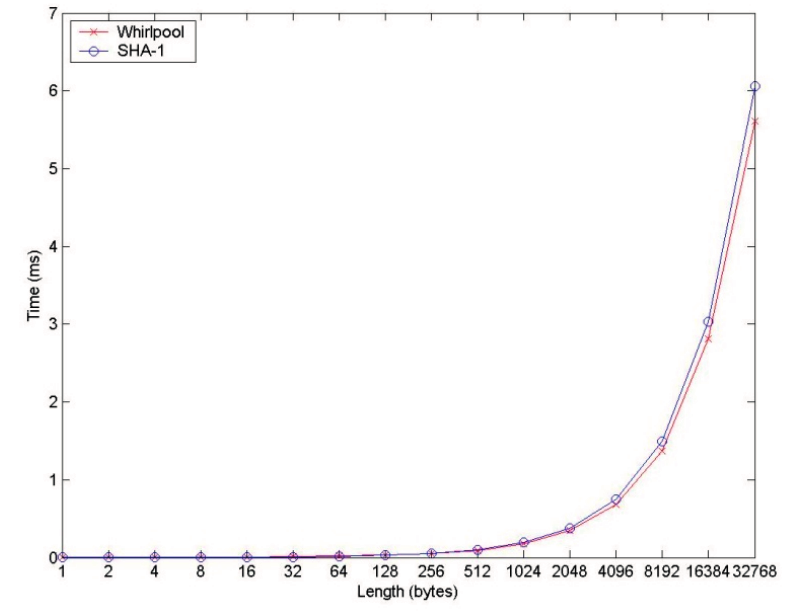
Figure 2. Comparison between Whirlpool and